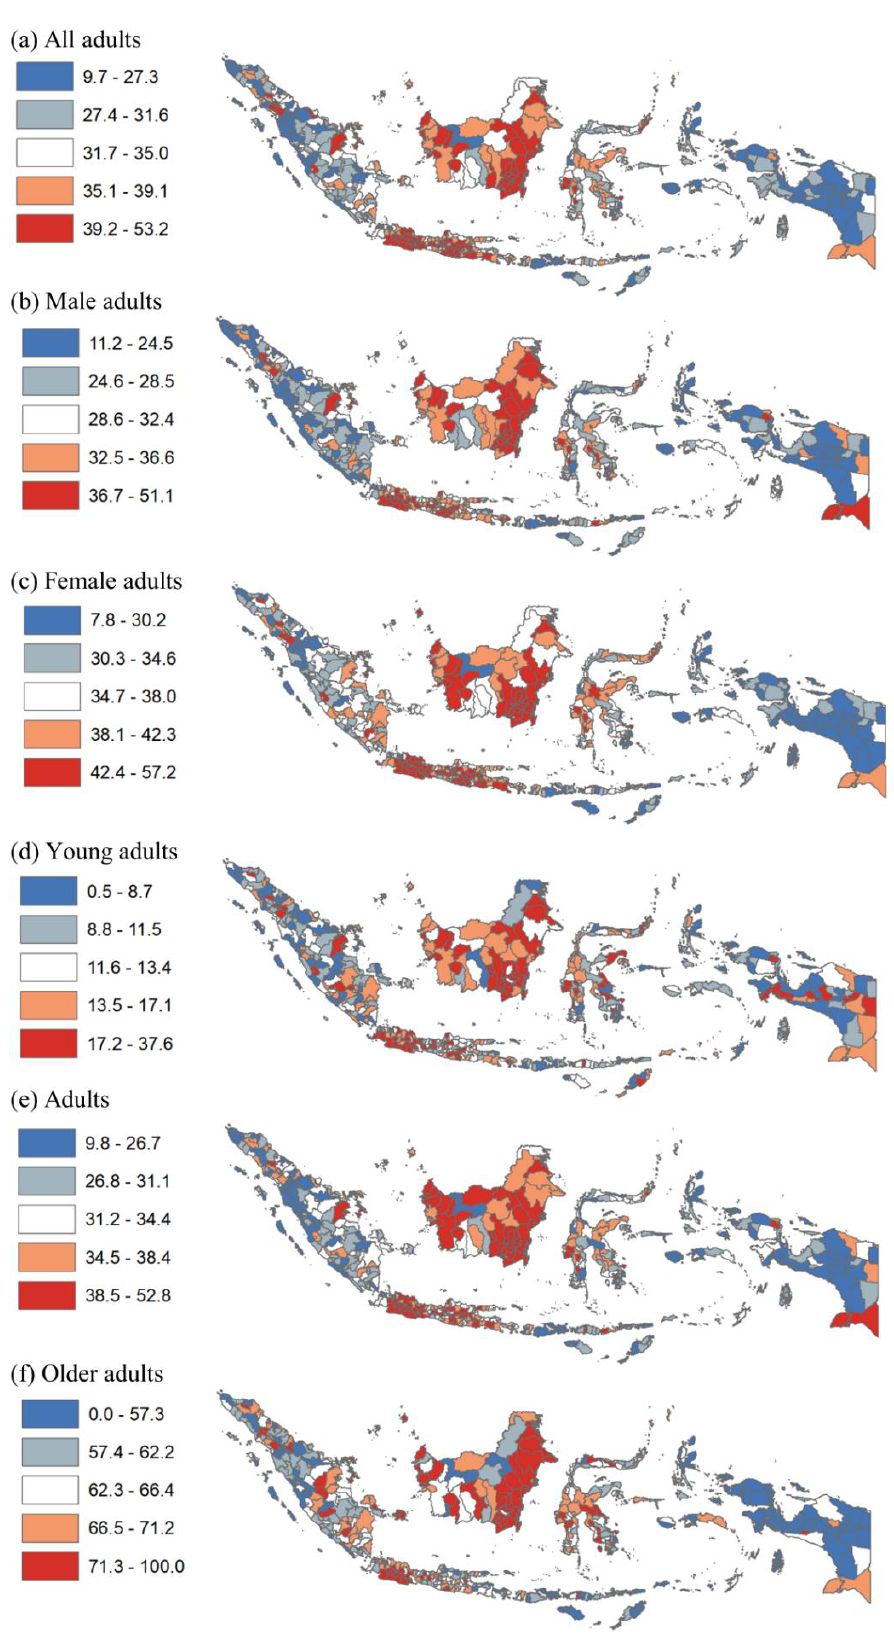
Figure 2. Disparity of hypertension among adults by district in Indonesia, 2018. Note: Numbers show prevalence of hypertension among all adults, males, females, young adults, adults, and older adults.